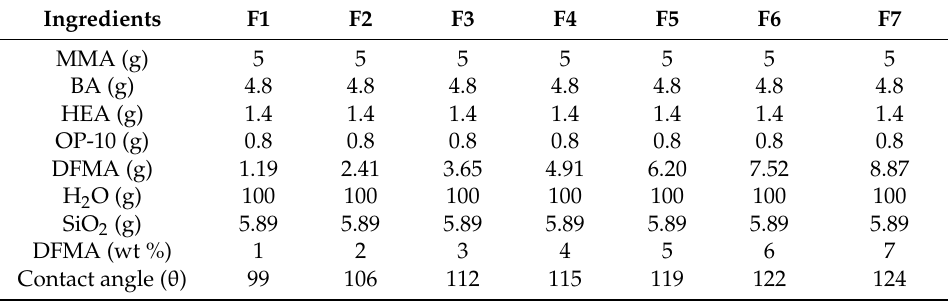
Table 2. Recipes for Nano-SiO 2 /fluorinated (Si/F) polyacrylate